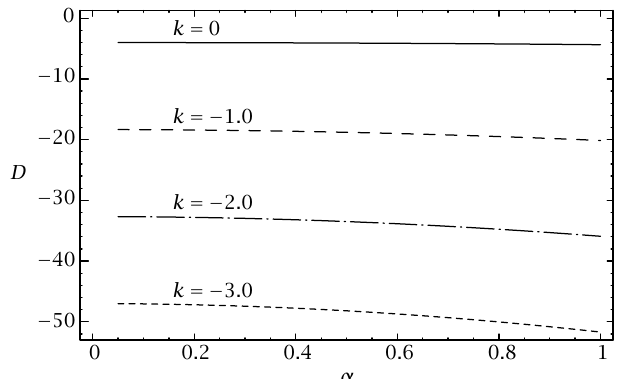
Figure 5.2 Variation of D with wave number α and Poiseuille parameter k at Re = 1 . 0.